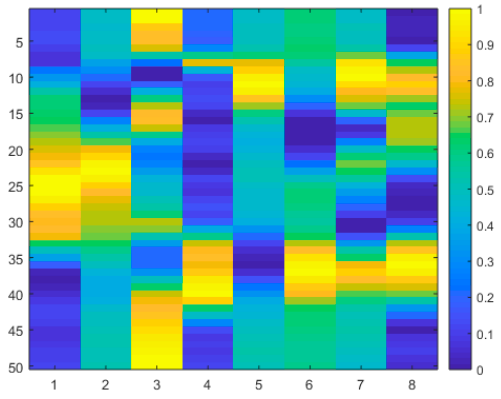
Figure 2. Example inertial signals image as input to the 2D convolution neural network.